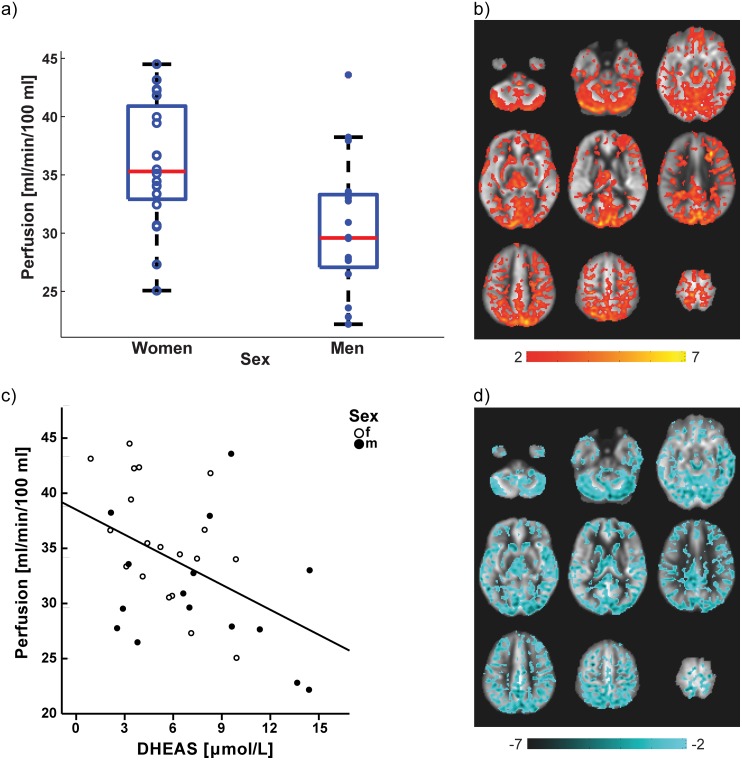
Women show higher perfusion than men and DHEAS correlates negatively with perfusion.a) Sex difference in whole brain grey matter perfusion: perfusion is higher in women (M = 35.97 ml/min/100 ml, SD = 5.37) than in men (M = 30.47 ml/min/100 ml, SD = 5.91, p = .006). Single dots represent the subjects' individual values. The horizontal line within the boxes indicate medians, the edges of the boxes are the 25th and 75th percentiles, and the whiskers represent 1.5 times the interquartile range. b) Sex difference (women > men) in regional perfusion: women show higher regional perfusion than men (p = .004, FWE-corrected). c) Simple regression analysis with whole brain perfusion values as the dependent variable and DHEAS as the only predictor: a significant model was found (p = .007, adjusted R
2 = .180) with a standardised β = -.452 for DHEAS. d) DHEAS effects in men and women: DHEAS correlates negatively with regional perfusion in both sexes (p = .004, FWE-corrected). Colour bar in a) and c) denotes a non-parametric t score, given by a1/[standard error(a1)], see methods. Images are shown in neurological orientation. Slices are at MNI z-coordinates -45, -30, -15, 0, 15, 30, 45, 60, 75 (from top left to bottom right).